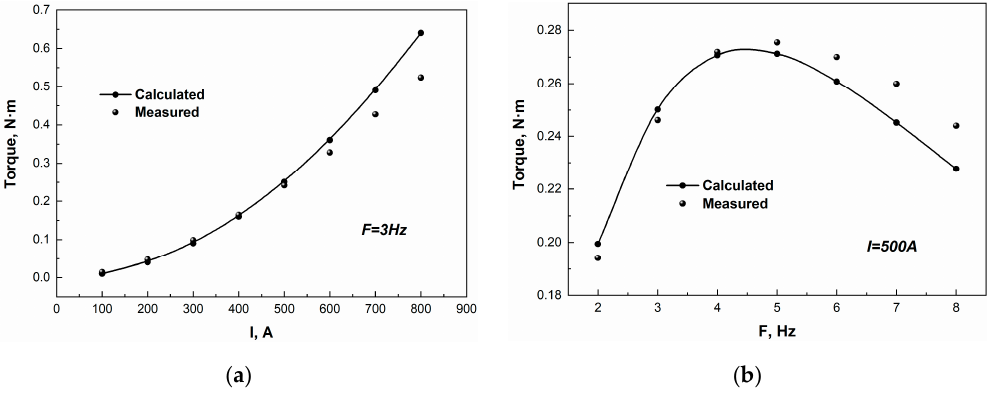
Figure 5. Comparison between predicted and measured data of the electromagnetic torque: ( a ) under different current intensity; ( b ) under different current frequency.